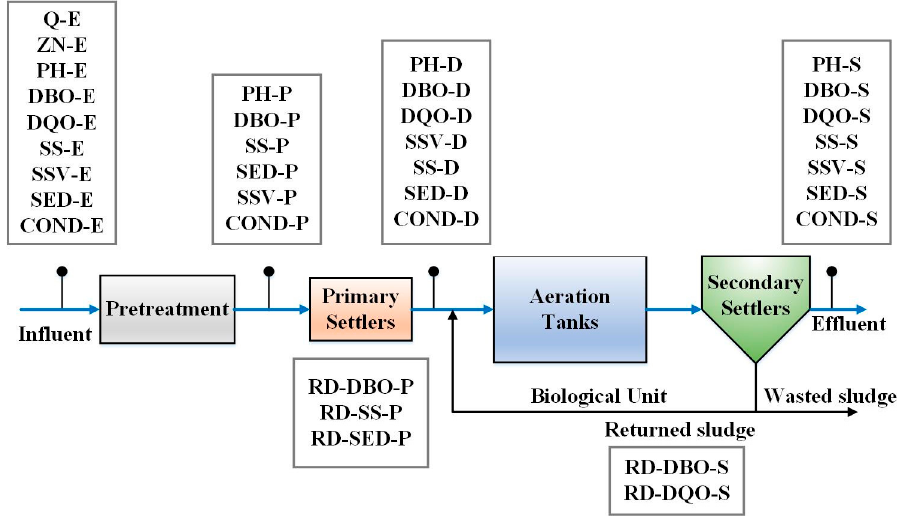
Figure 3. Process of wastewater treatment.